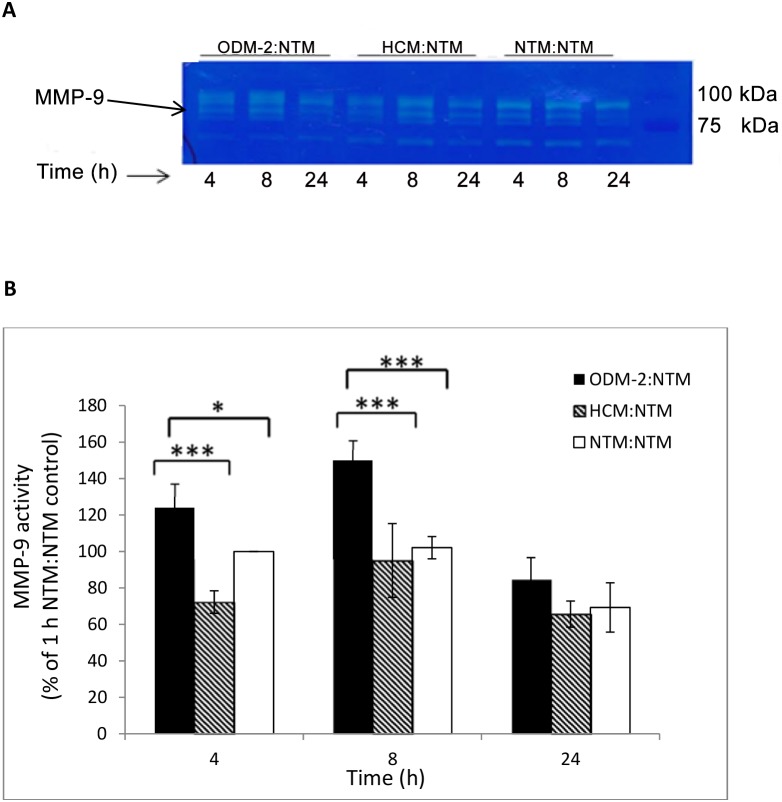
MMP-9 activity following ODM-2 and NTM cells co-culture.Gelatinolytic activity of MMP-9 (92kDa) in NTM cells was examined by gelatin zymography after 4, 8, and 24h of co-culture with ODM-2 cells. As controls, NTM cells were co-cultured with HCM or NTM cells. (A) Zymogram of co-culture groups. (B) MMP-9 quantitative analysis of NTM cells co-cultured with ODM, NTM or HCM cells for 4, 8 and 24h. The bar graph represents the means ± SD of three independent experiments performed in duplicate; one-way ANOVA (*p<0.05, ***p<0.001).